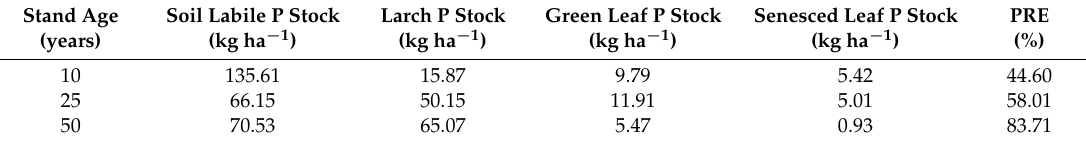
Table 5. The stock of soil labile P and larch P.